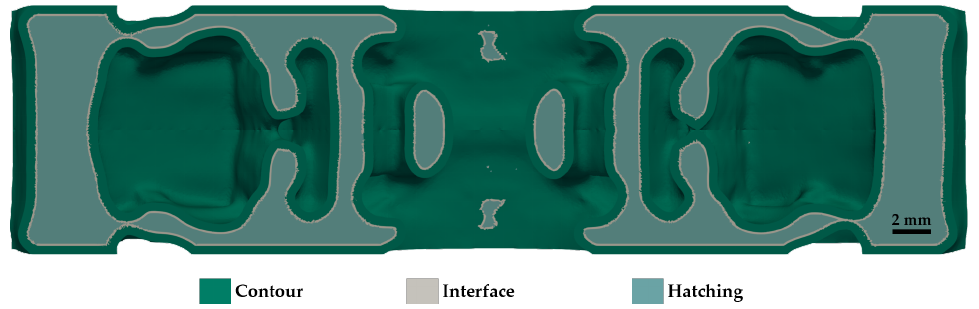
Figure 24. Section in layer plane through the design resulting from the developed optimization method for optimization case 2 (top view).